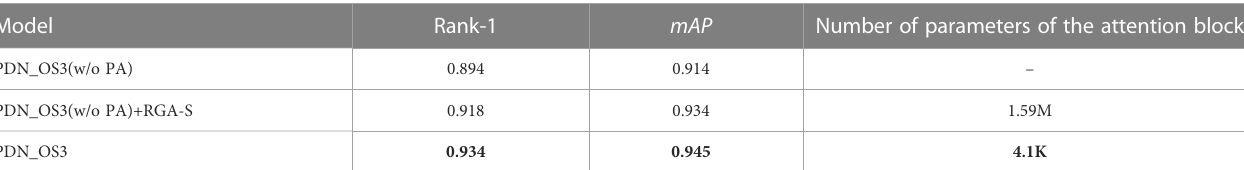
TABLE 1 Comparison of the attention